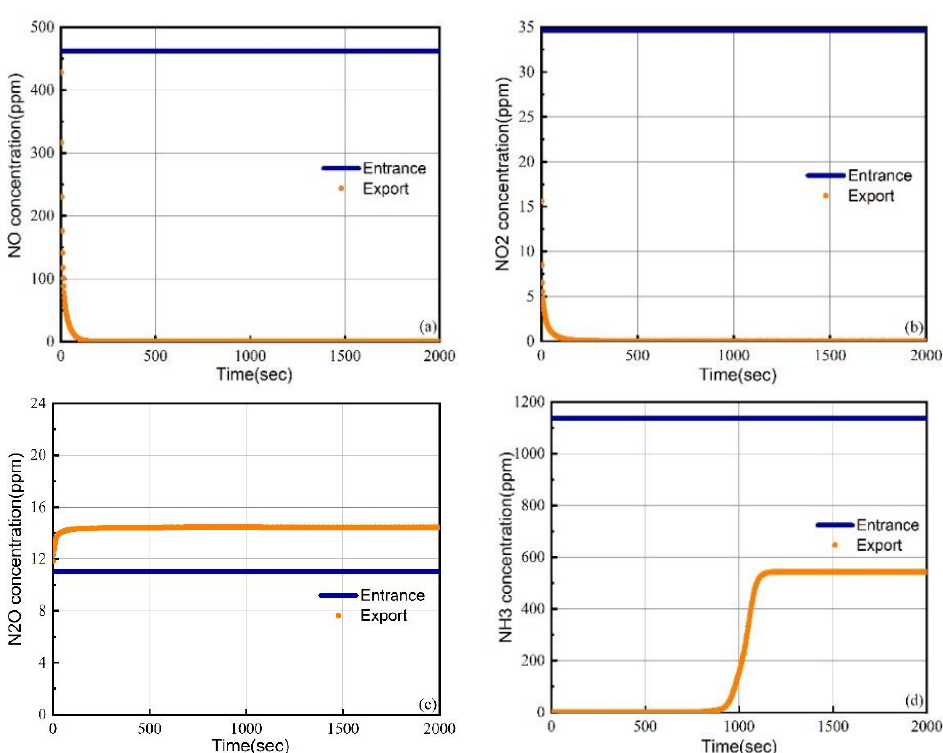
Figure 9. Comparison of NO X and unburned ammonia concentrations at the SCR inlet and outlet in Case 2. ( a ) NO concentration on entrance and export. ( b ) NO 2 concentration on entrance and export. ( c ) N 2 O concentration on entrance and export. ( d ) NH 3 concentration on entrance and export.